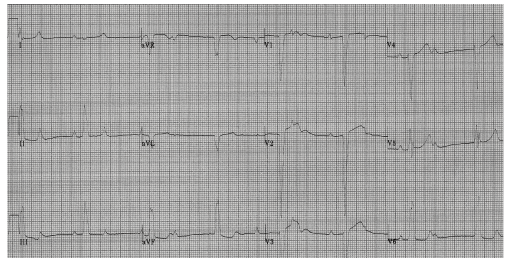
Figure 1: EKG showing complete heart block with ventricular escape rhythm.